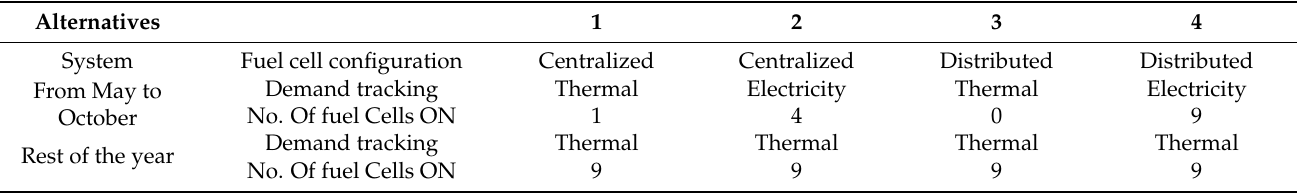
Table 7. Characteristics of each alternative for a cogeneration system with a thermal power of 4 MW of